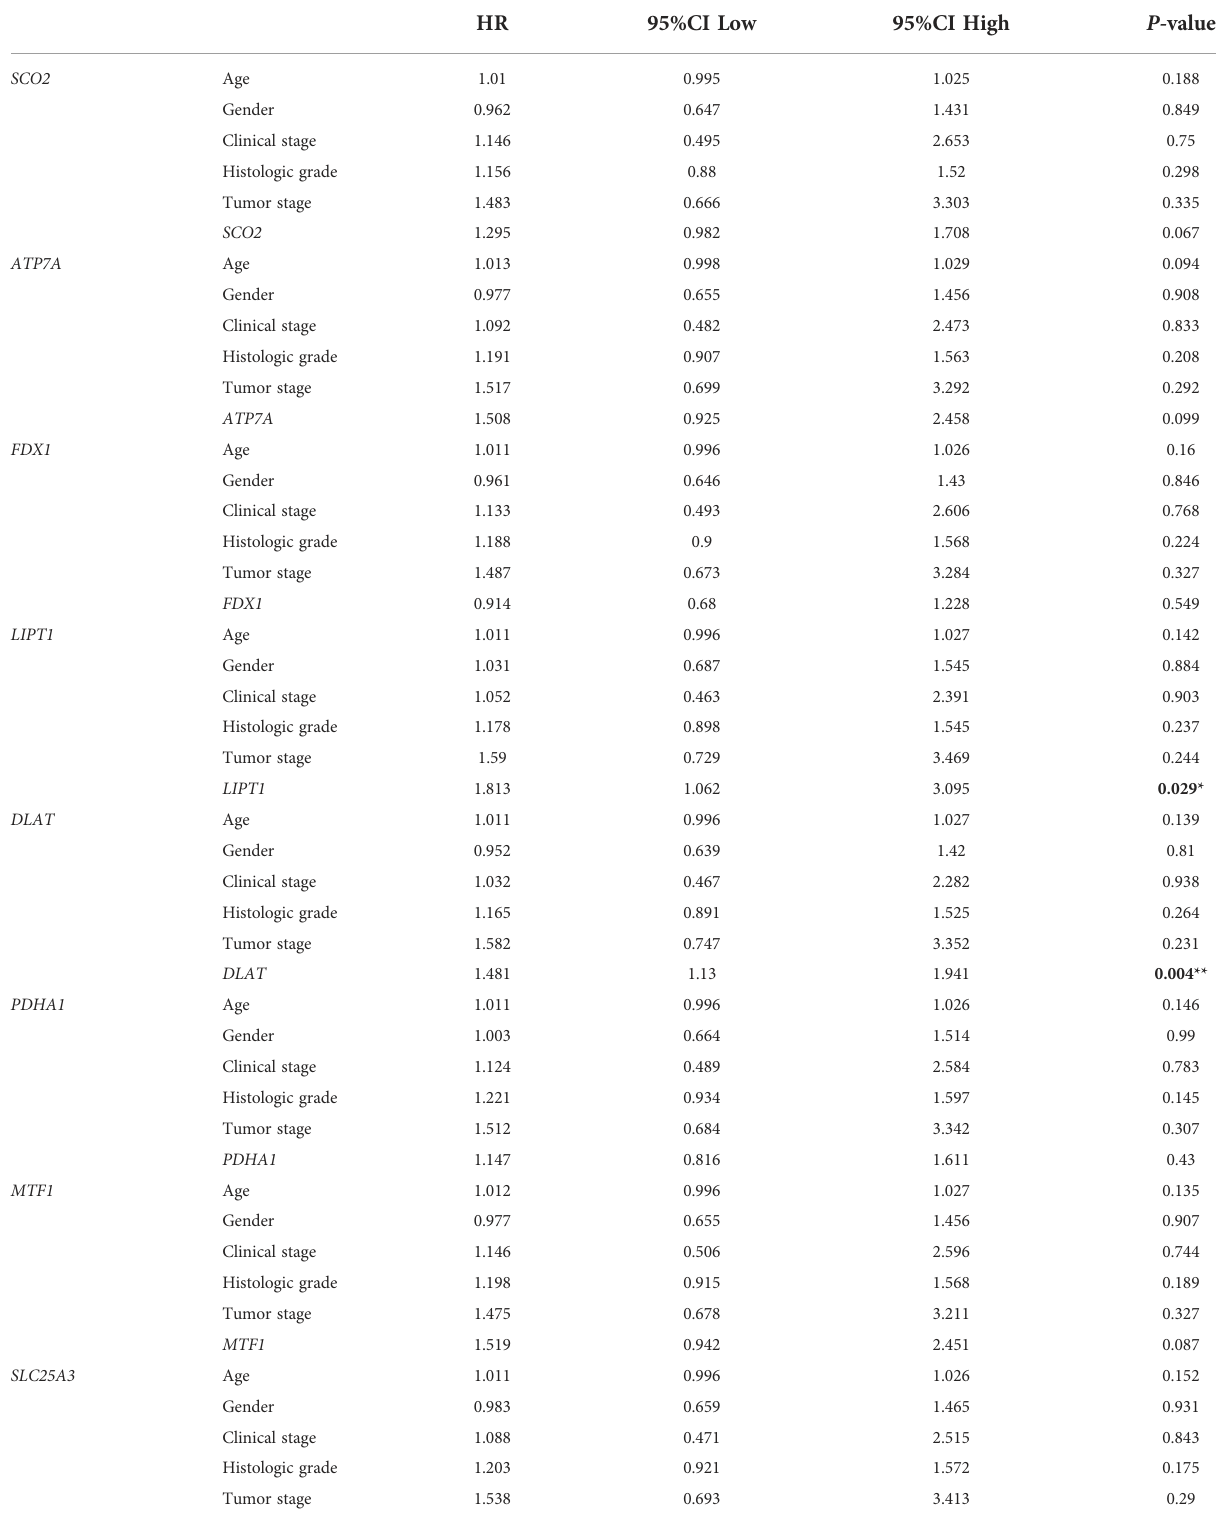
TABLE 2 Multivariate Cox regression analysis for prognosis risk factors of HCC